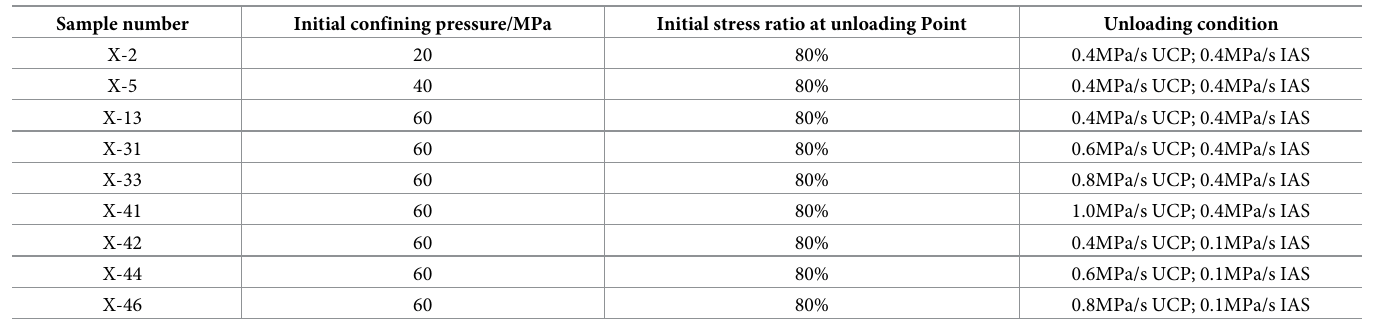
Table 2. The parameters of shale samples under unloading confining pressure test.